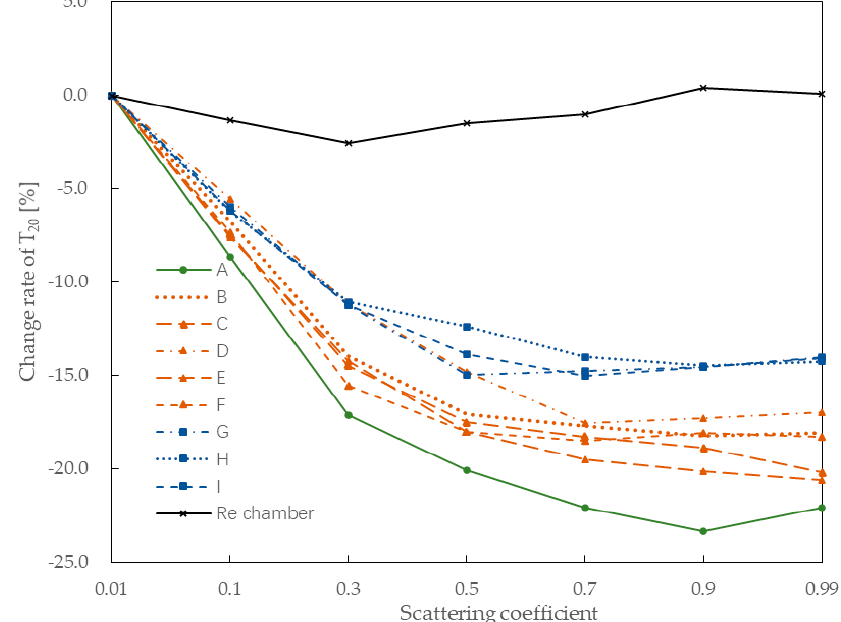
Figure 5. The impact of the scattering coefficient on the T 20 change rate under the same volume and different shapes Note: A—rectangular space, B—single sidewall tilted, C—both sidewall tilted, D—backwall tilted, E—both sidewalls and backwall are tilted at the same time, F—ceiling tilted, G—single sidewall tilted, H—both sidewalls and ceiling are tilted at the same time, I—all sidewalls and ceiling are tilted at the same time, Re Chamber— reverberation chamber.